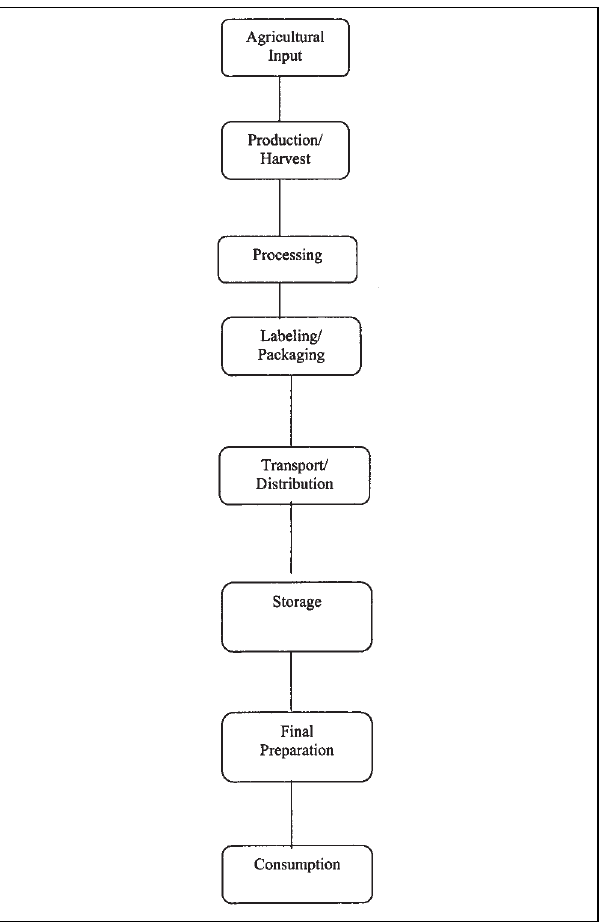
Figure 1) ‘From farm to plate’ – The food supply